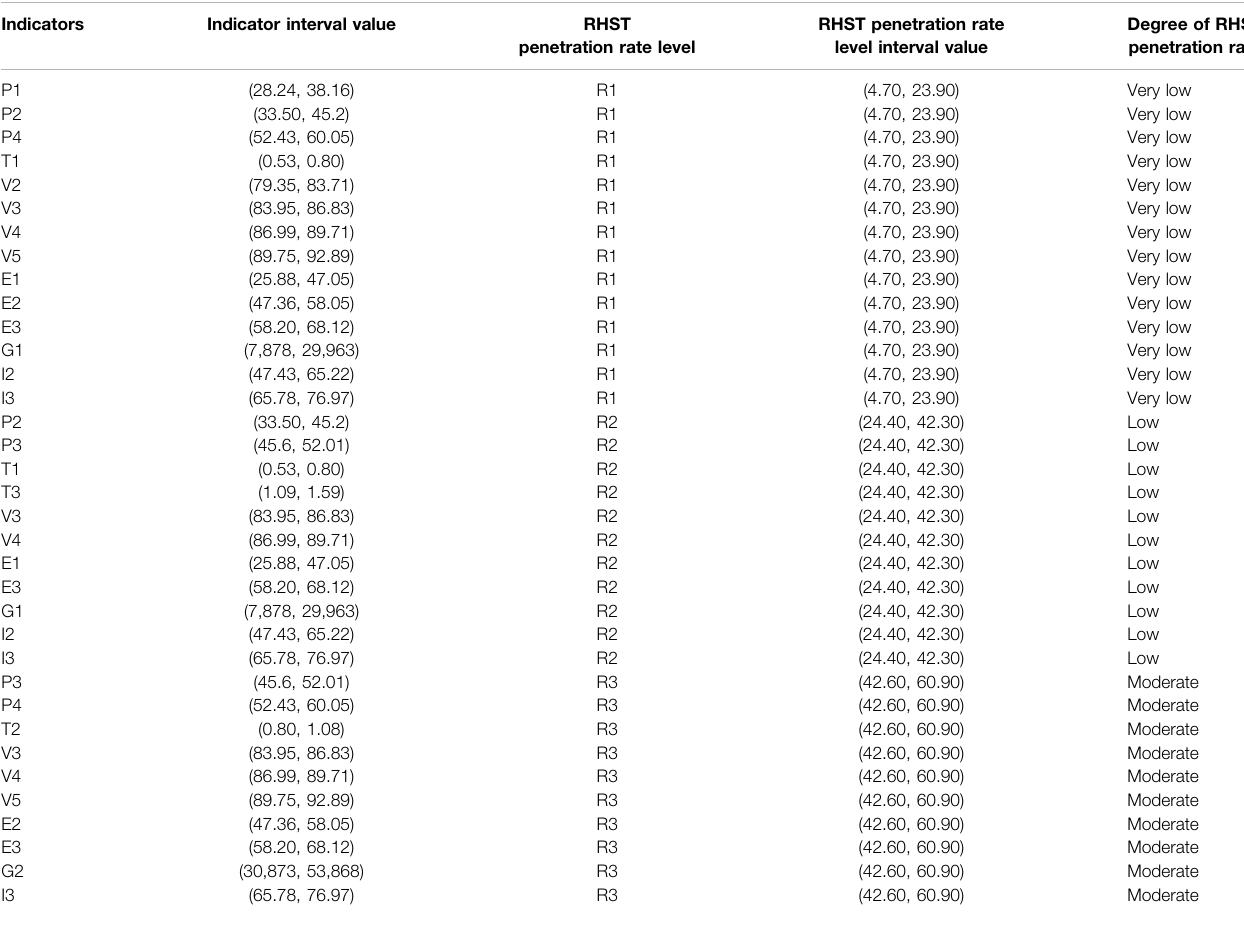
TABLE 3 | Association rules between one SED indicator and penetration rate of RHST.